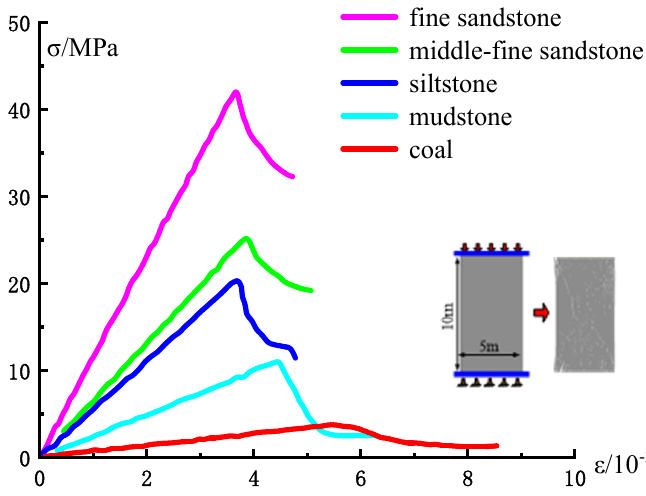
Figure 5. Uniaxial compression test and stress–strain curve of rock mass.